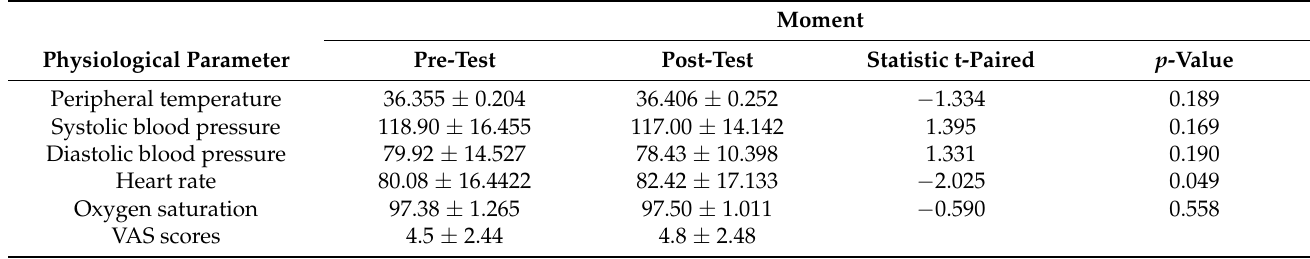
Table 2. Physiological and psychological variables at pre-test and post-test moments.